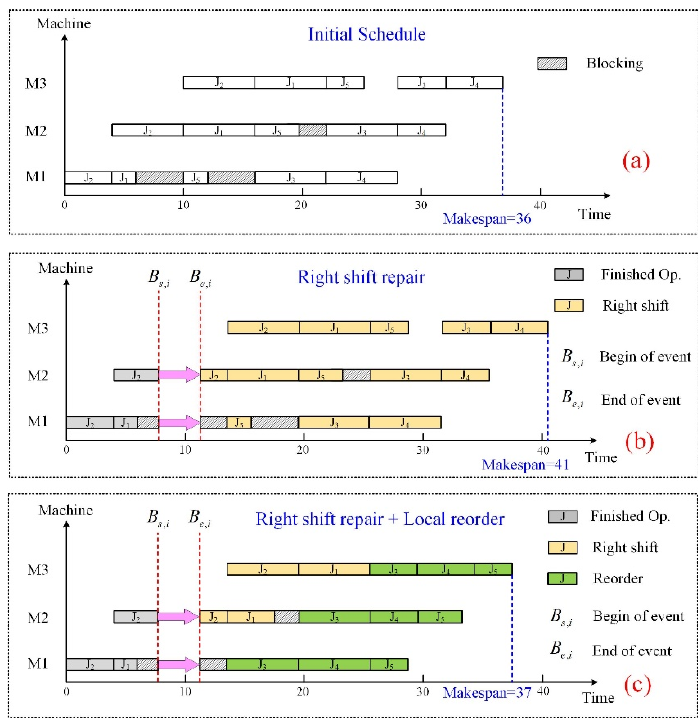
Figure 3. Comparison of different rescheduling strategies.